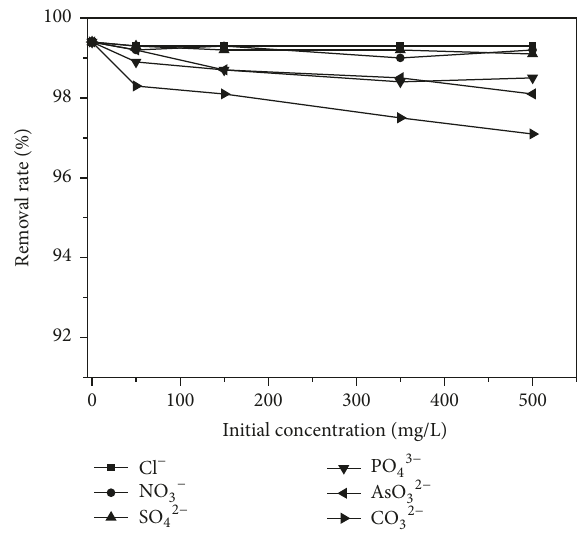
Figure 8: Effects of the coexisting ions.